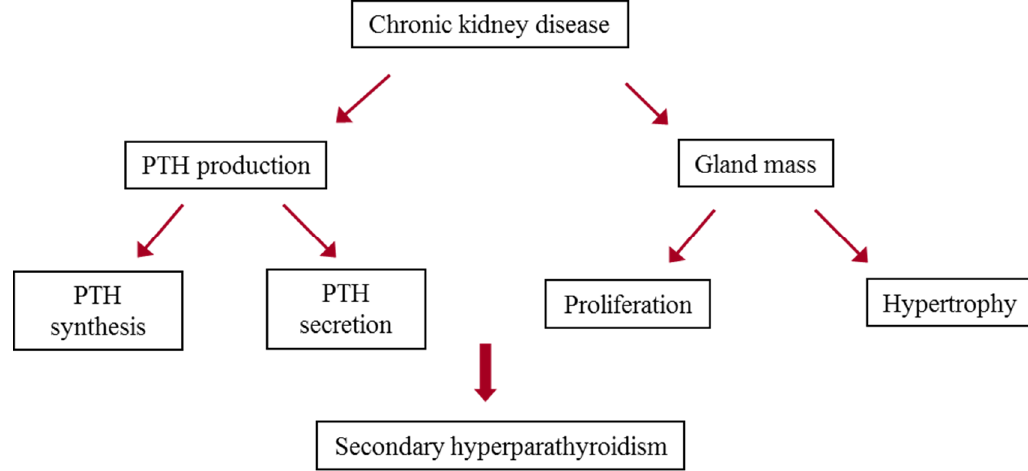
Figure 1. Pathogenesis of secondary hyperparathyroidism (SHP) in chronic kidney disease. There are two major mechanisms which determine the magnitude of SHP: Increased parathyroid hormone (PTH) production composed of PTH synthesis and secretion per cell, and increased parathyroid gland mass, mostly due to parathyroid cell proliferation and, to a lesser degree, increased cell size (hypertrophy).